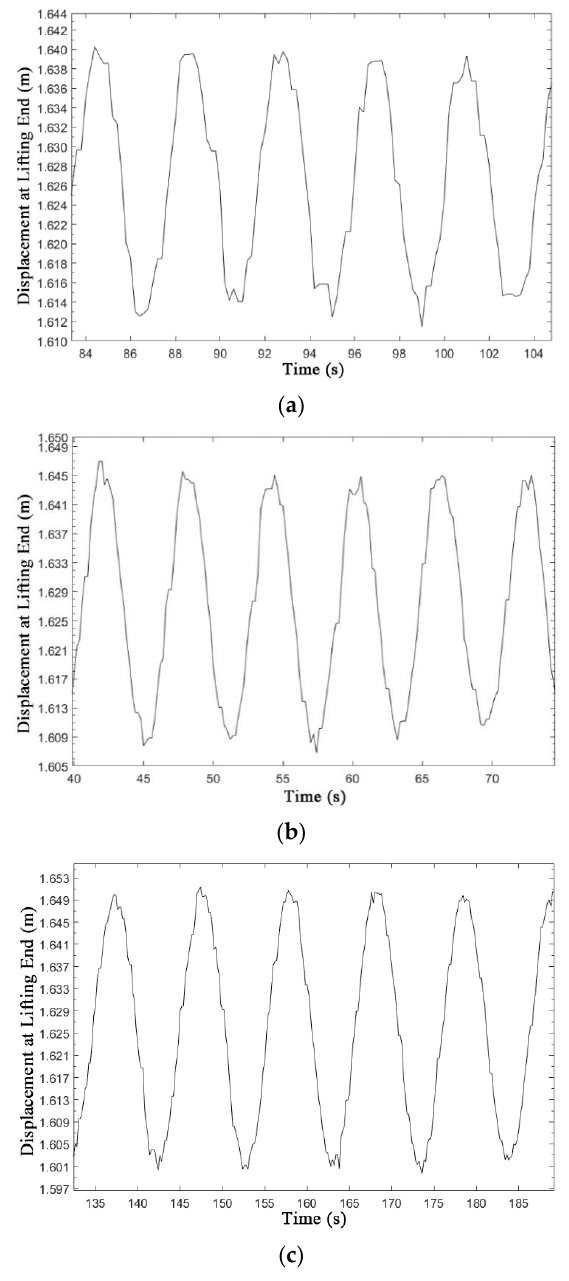
Figure 20. Curve of the Displacement in the Vertical Direction at the Lifting End: ( a ) under 3rd ‐ grade sea states, ( b ) under 4th ‐ grade sea states and ( c ) under 5th ‐ grade sea states.